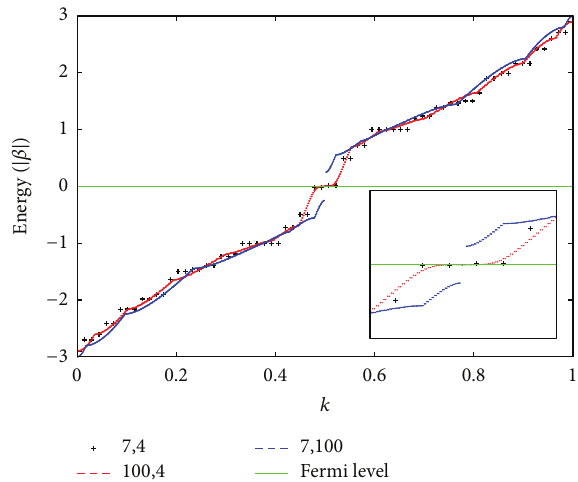
Figure 1: H¨uckel orbital energies for the nanotube (6 4) , where |𝛽| is the energy unit and 𝑘 is the normalized orbital number.